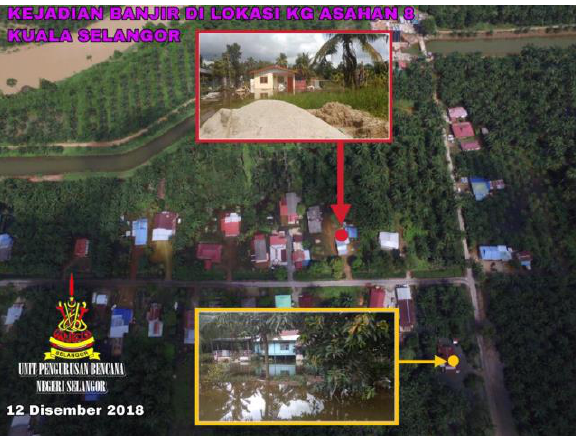
Figure 2. The Aerial View of Flood Occurred at